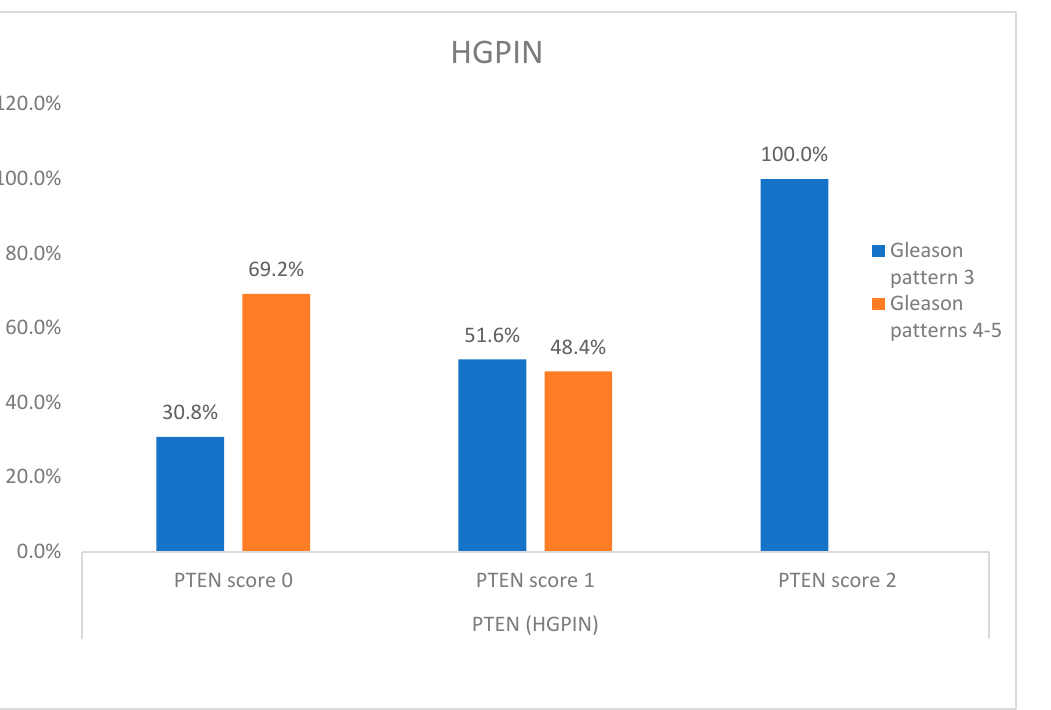
Figure 5. PTEN scores in HGPIN in relation to PTEN score and Gleason grade pattern of the adjacent carcinoma.